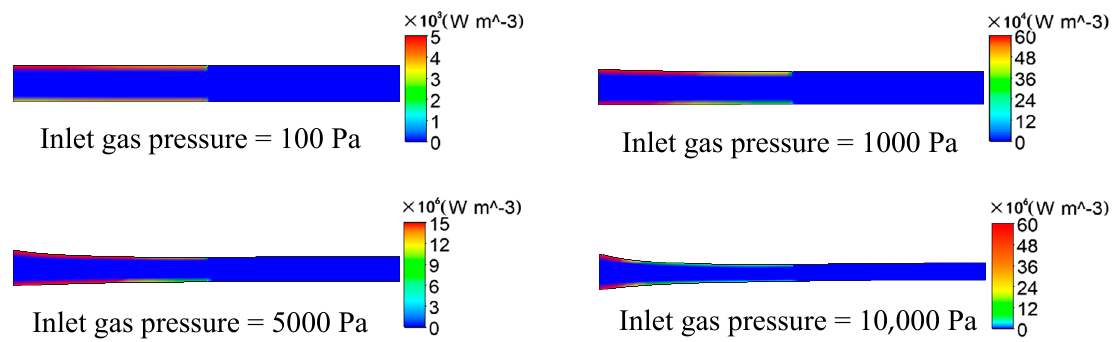
Figure 8. Distributions of viscous heating under different inlet gas pressures.